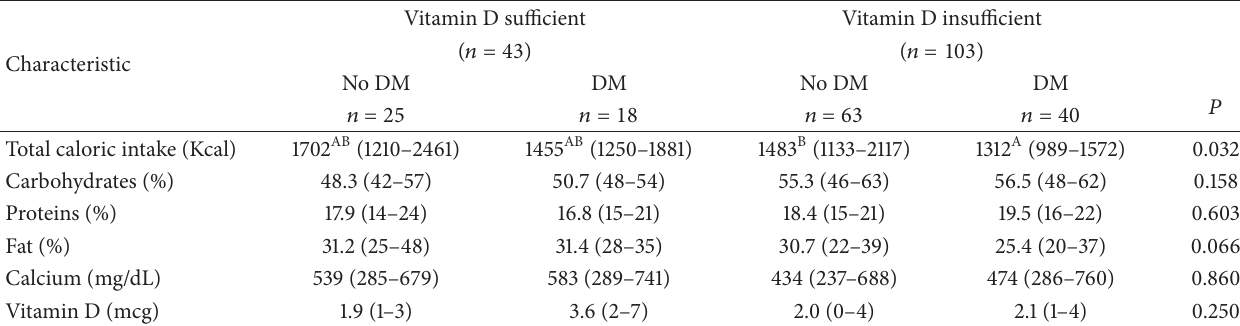
Table 2: Food intake and caloric consumption according to vitamin D and diabetes mellitus.